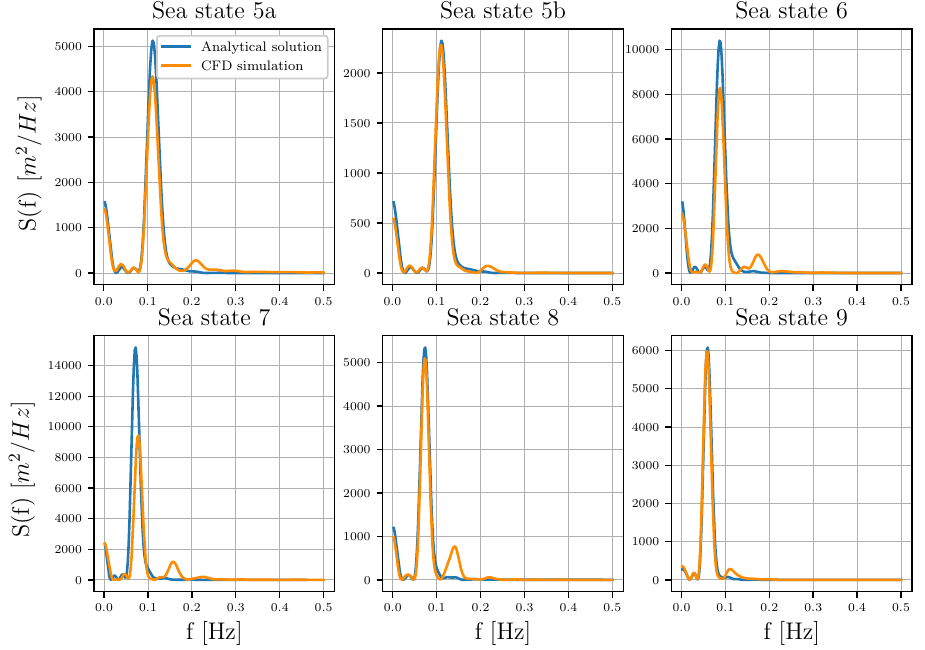
Figure 10. Wave frequency spectra as obtained by Fourier transformation implemented in the time series shown in Figure 9. The CFD solution is compared with the